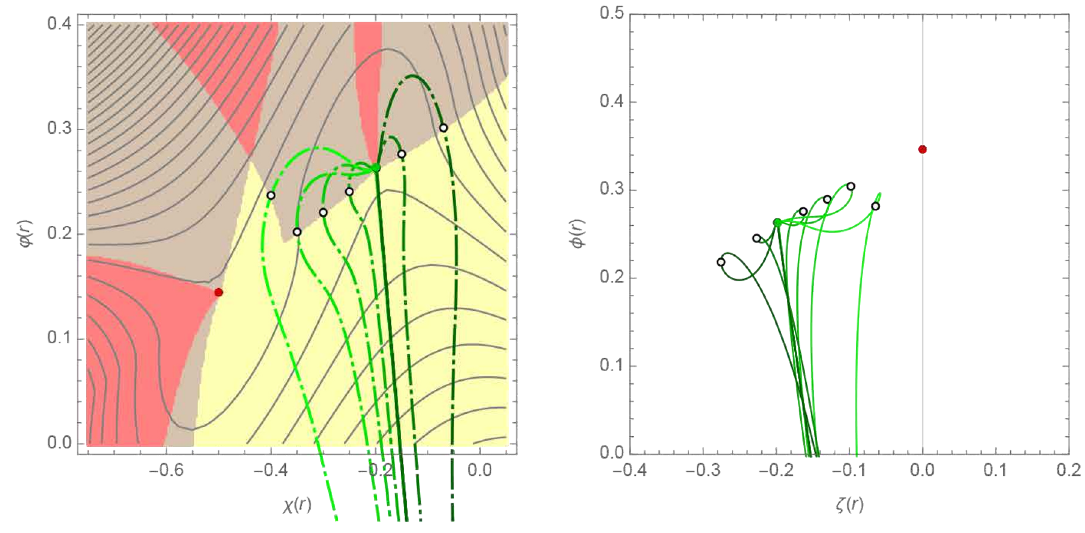
Figure 12. Space of N = 1 Janus solutions with SU(3) symmetry that approach the G 2 critical point.